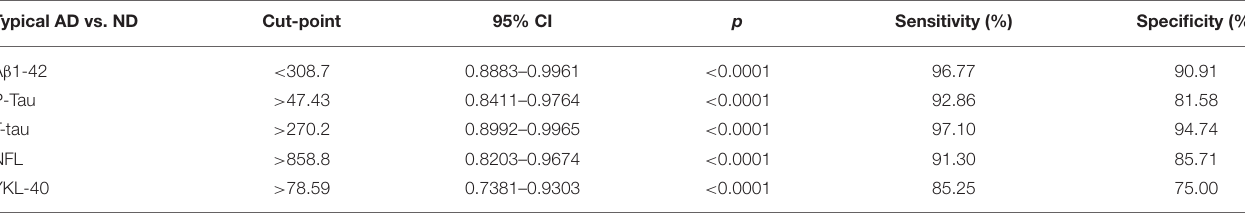
TABLE 4 | Diagnostic values of CSF biomarkers in the typical AD patients vs. ND. Typical AD vs.